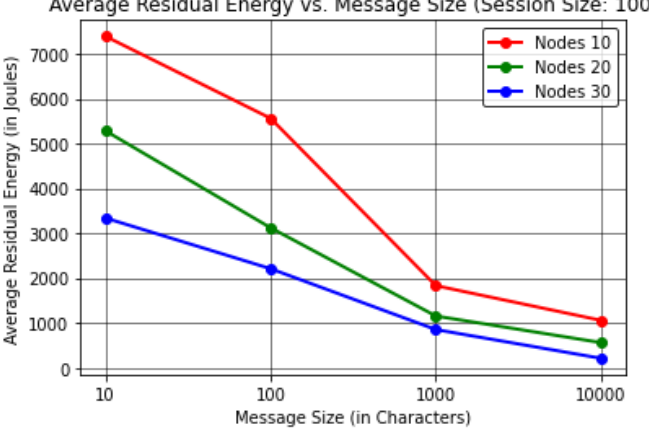
Figure 8. Average residual energy vs. message